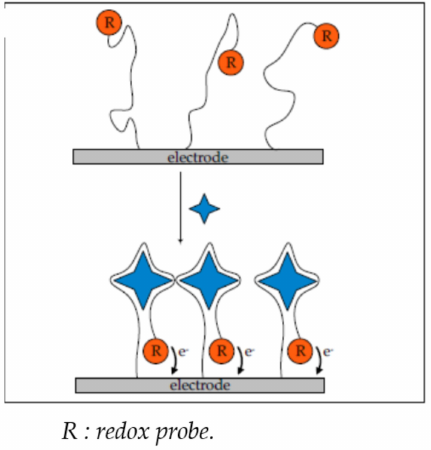
Figure 5. Working principle of a labelled electrochemical aptasensor based on target induced conformation change. The aptamer was previously labelled with a redox probe on its free extremity. The aptamer conformation was modified in the presence of the target analyte (a) the distance between the redox probe to the electrode surface was decreased (“signal on”). Reprinted from reference [16].